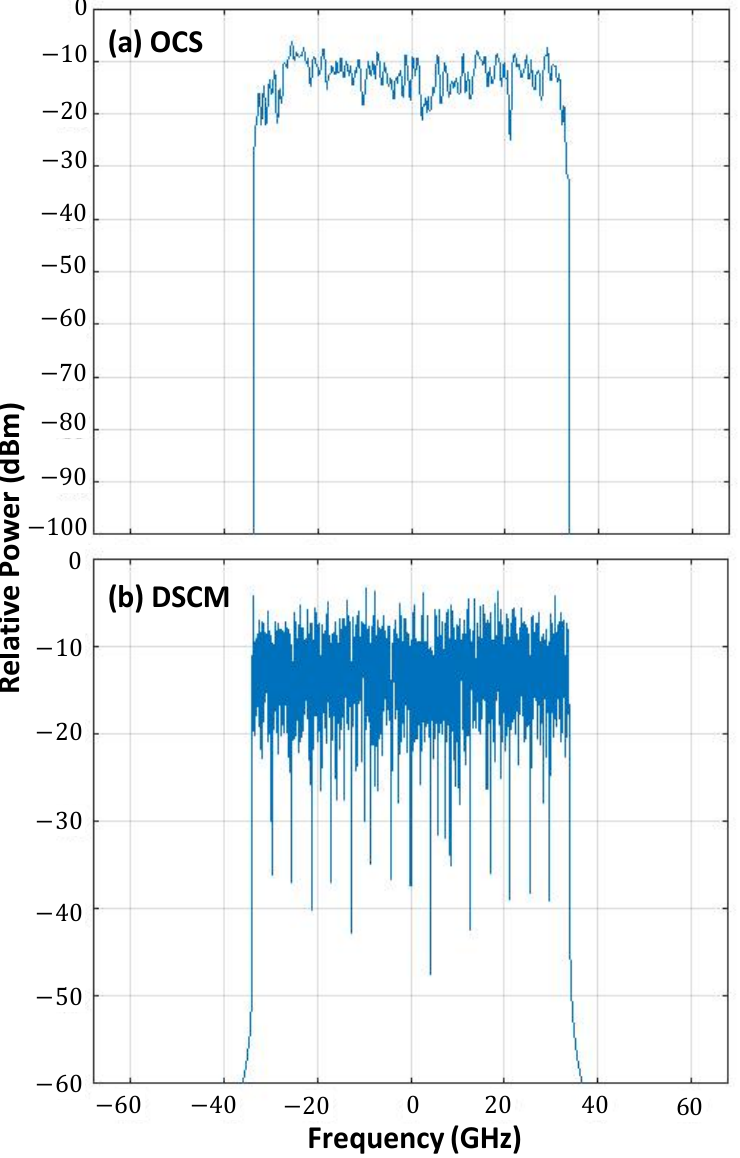
Figure 6. Spectrum of the single carrier signal used for OCS ( a ) and 16 SC DSCM ( b ).